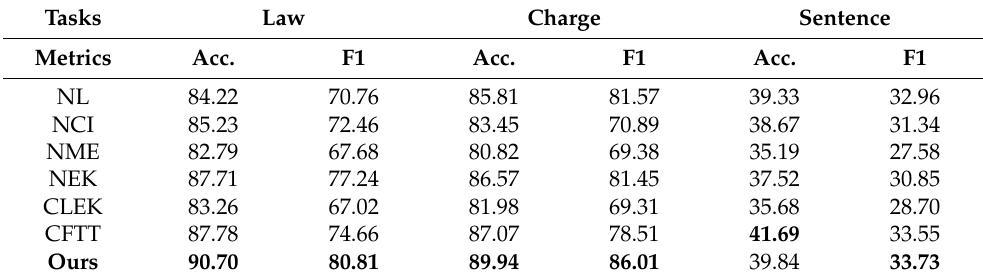
Table 7. Results of decision prediction on CAIL-small in ablation